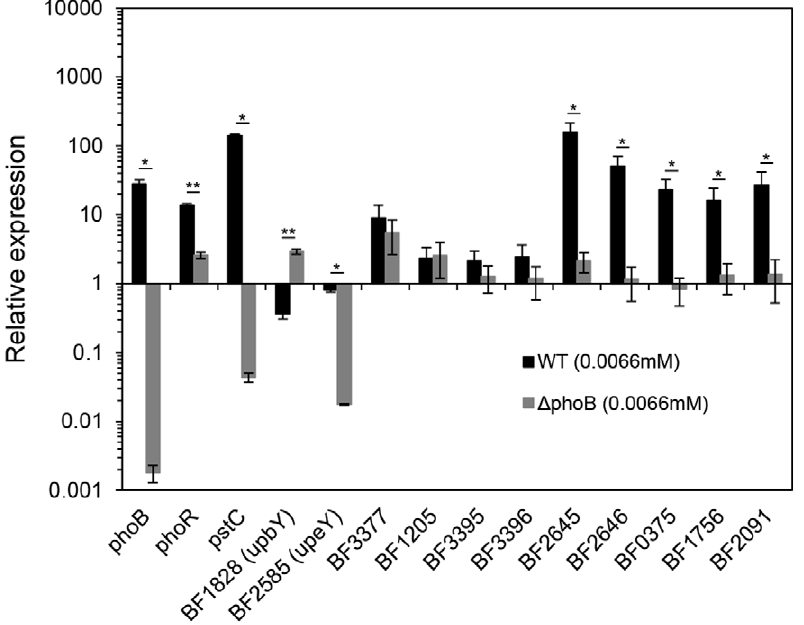
Figure 7. qPCR verification of differentially expressed PhoB-dependent genes identified by microarray analysis. The transcriptional levels of representative genes in wild type (closed column) and phoB deletion mutant (open column) under Pi limitation (0.0066 mM of KH 2 PO 4 ) is shown in relation to those in wild type under Pi rich condition (6.6 mM of KH 2 PO 4 ). Annotation of each gene is as listed in Table 2: BF1576 (PhoB), BF1575 (PhoR), BF2185 (PstC), BF1828 (UpbY, product of the first gene product in PS B), BF2585 (UpbY, product of the first gene product in PS E), BF3377 (DnaJ), BF1205 (endopeptidase Clp), BF3395 (GroEL), BF3396 (GroES), BF2645 (polyphoaphate kinase), BF1576 (alkaline phosphatase), and BF2091 (cation efflux system protein). **Significantly different from the wild type strain, *Significantly different from the wild type strain ( p , 0.05).